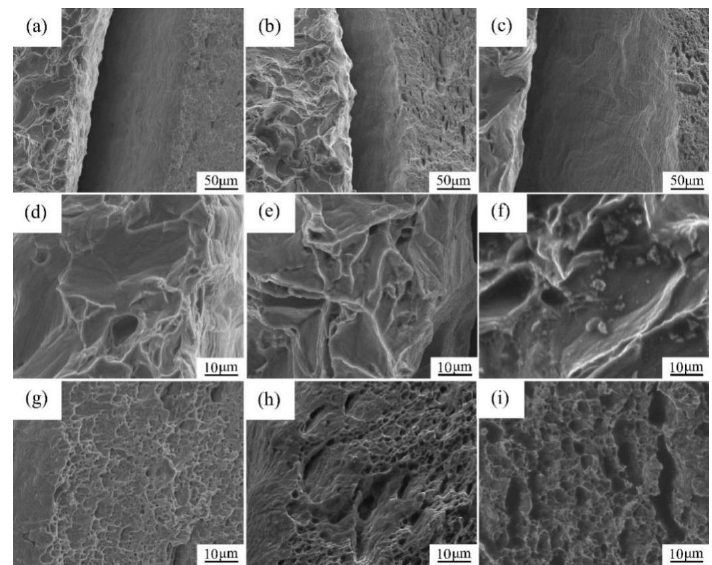
Figure 13. Macroscopic morphology of sheets rolled at different temperatures after tensile fracture.